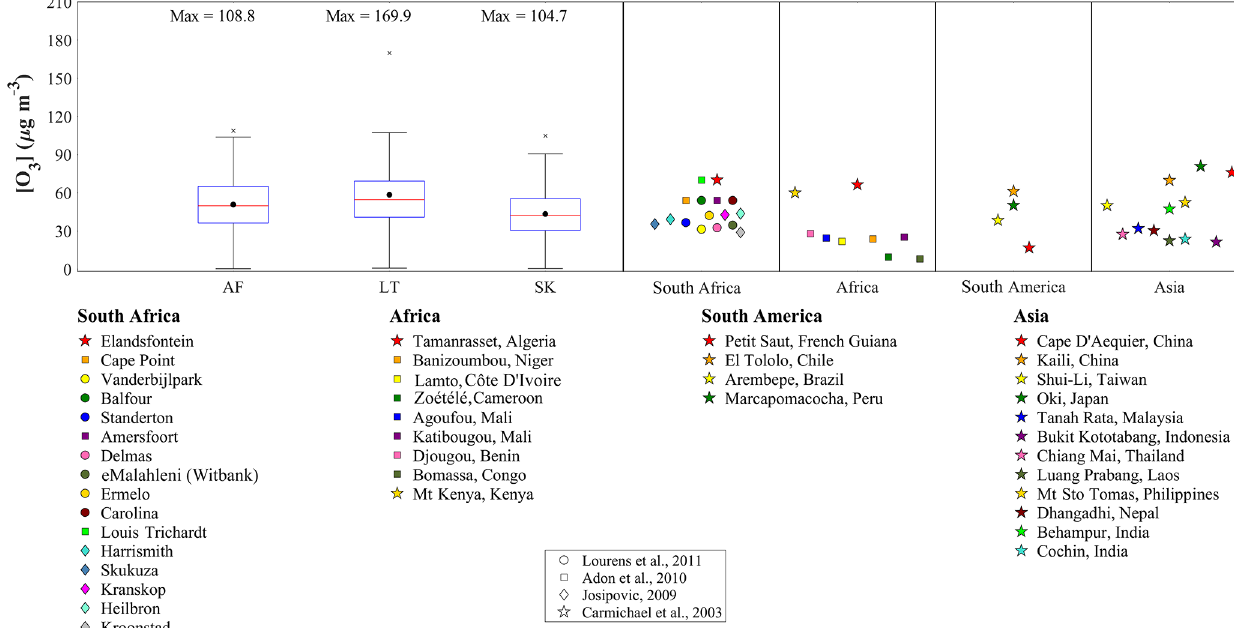
Figure 14. Statistical spread of O 3 concentrations determined during the entire measuring period at each site compared to mean levels determined with passive samplers elsewhere. The red line of each box represents the median; the top and bottom edges of the box represent the 25th and 75th percentiles, respectively; the whiskers are ± 2 . 7 σ (99.3% coverage if the data have a normal distribution); and the black dots represent the average